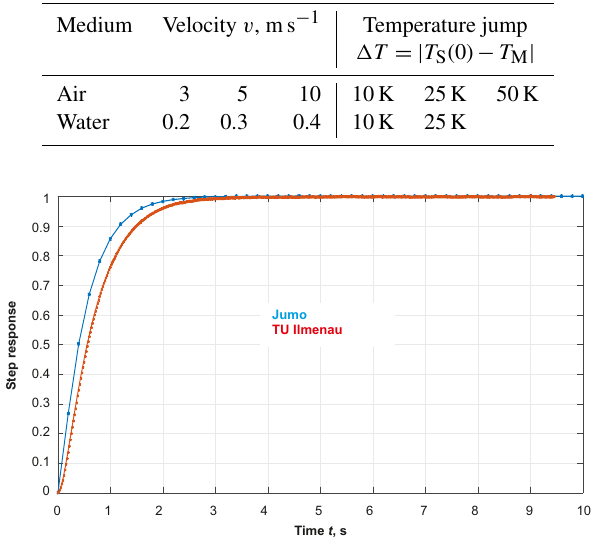
Figure 7. Step response in water for the thermocouple d = 3mm, v = 0.4ms − 1 and (cid:49)T =